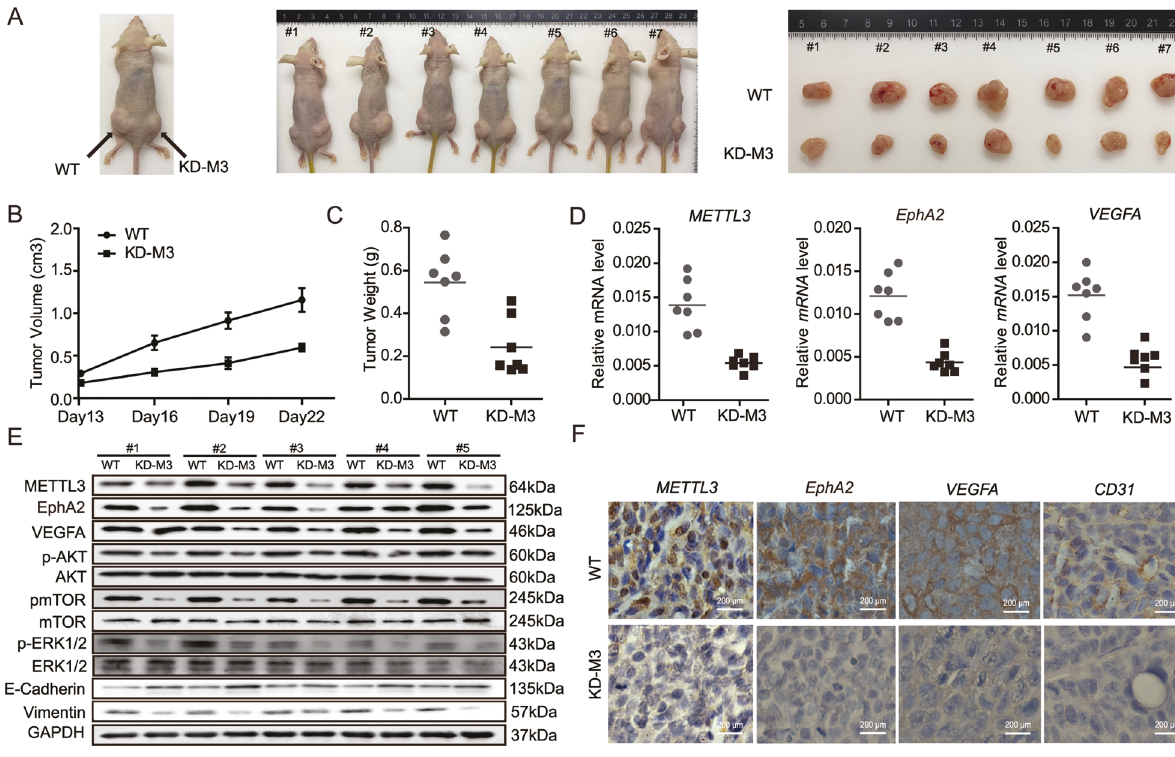
Fig. 6 METTL3 modi fi cation of EphA2/VEGFA promotes VM in CRC cells via PI3K/AKT and ERK1/2 signaling in vitro and in vivo. A METTL3 deletion HCT116 cells and control cells were injected into fl anks of nude mice and the representative mice were presented. B Tumor growth curve after the injection of METTL3-de fi cient HCT116 cells and control cells into nude mice ( n = 7). C Tumors weight was measured. D , E The expression of EphA2/VEGFA in tumors was detected by qRT-PCR and AKT/ERK1/2 signaling pathway was detected through western blotting. F Representive images of IHC staining for METTL3, EphA2, VEGFA and CD31 protein on a tumor tissue. p values were calculated using t test from three independent experiments. * p <